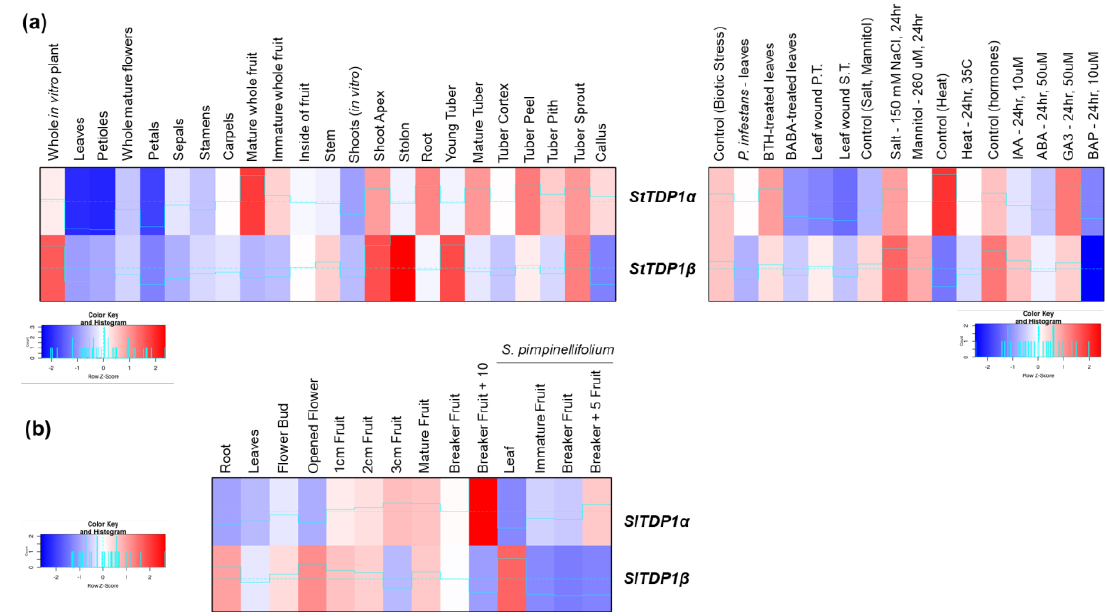
Figure 6. Expression profiles of the TDP1α and TDP1β genes in cereal crops. ( a ) S. tuberosum. ( b ) S. lycopersicum and S. pimpinellifolium wild relative. Expression data from different tissues and stress conditions are given in heatmaps generated based on Z-score values at http://shinyheatmap.com/.